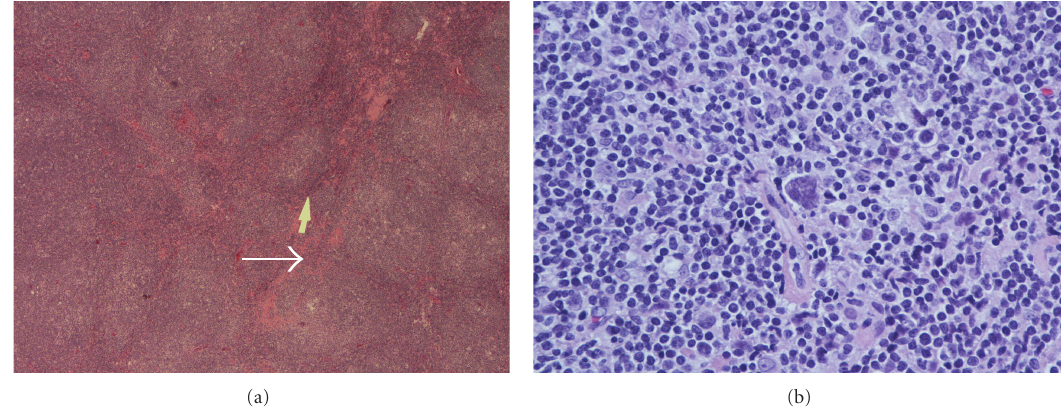
Figure 2: (a) Showing lymph node with vague nodularity morphology as indicated by the arrows (magnification 40x). (b) shows multinucleated (classical) Reed-Stemberg cell. (40x magnification).